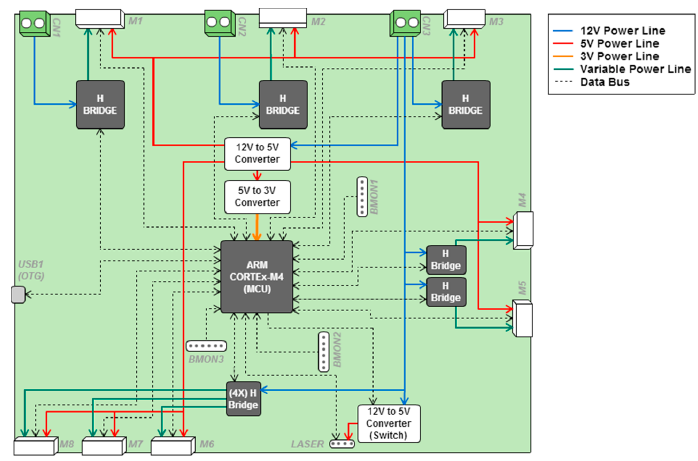
Figure 5. Schematic representation of the motor control board (MCB) of the APR.